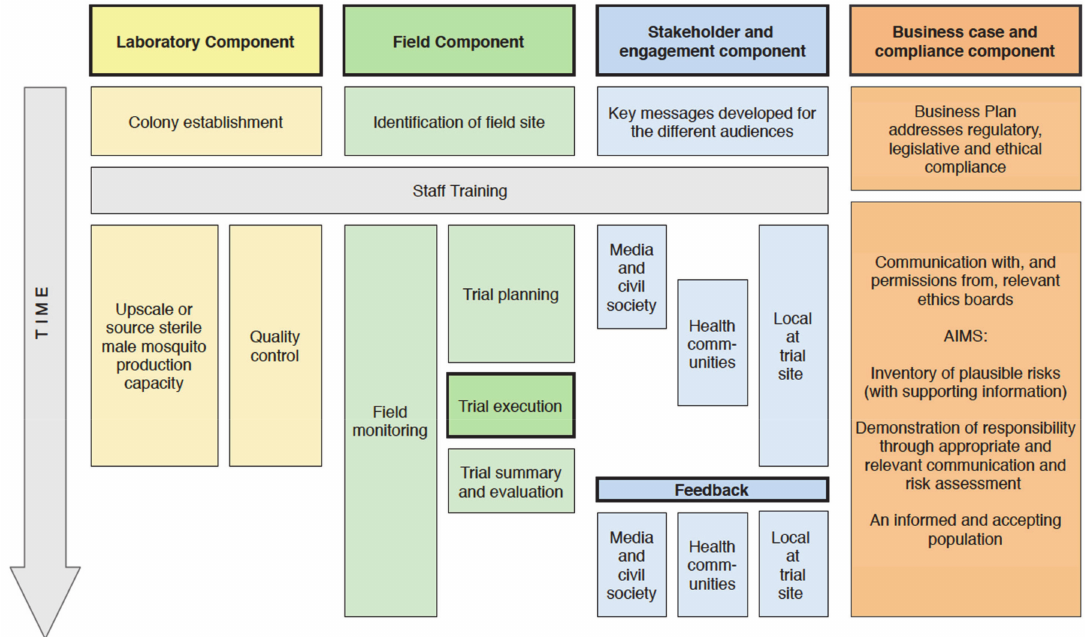
Figure 2. Illustrative timeline of the steps towards the implementation of a sterile insect technique (SIT) pilot field trial for vector mosquito